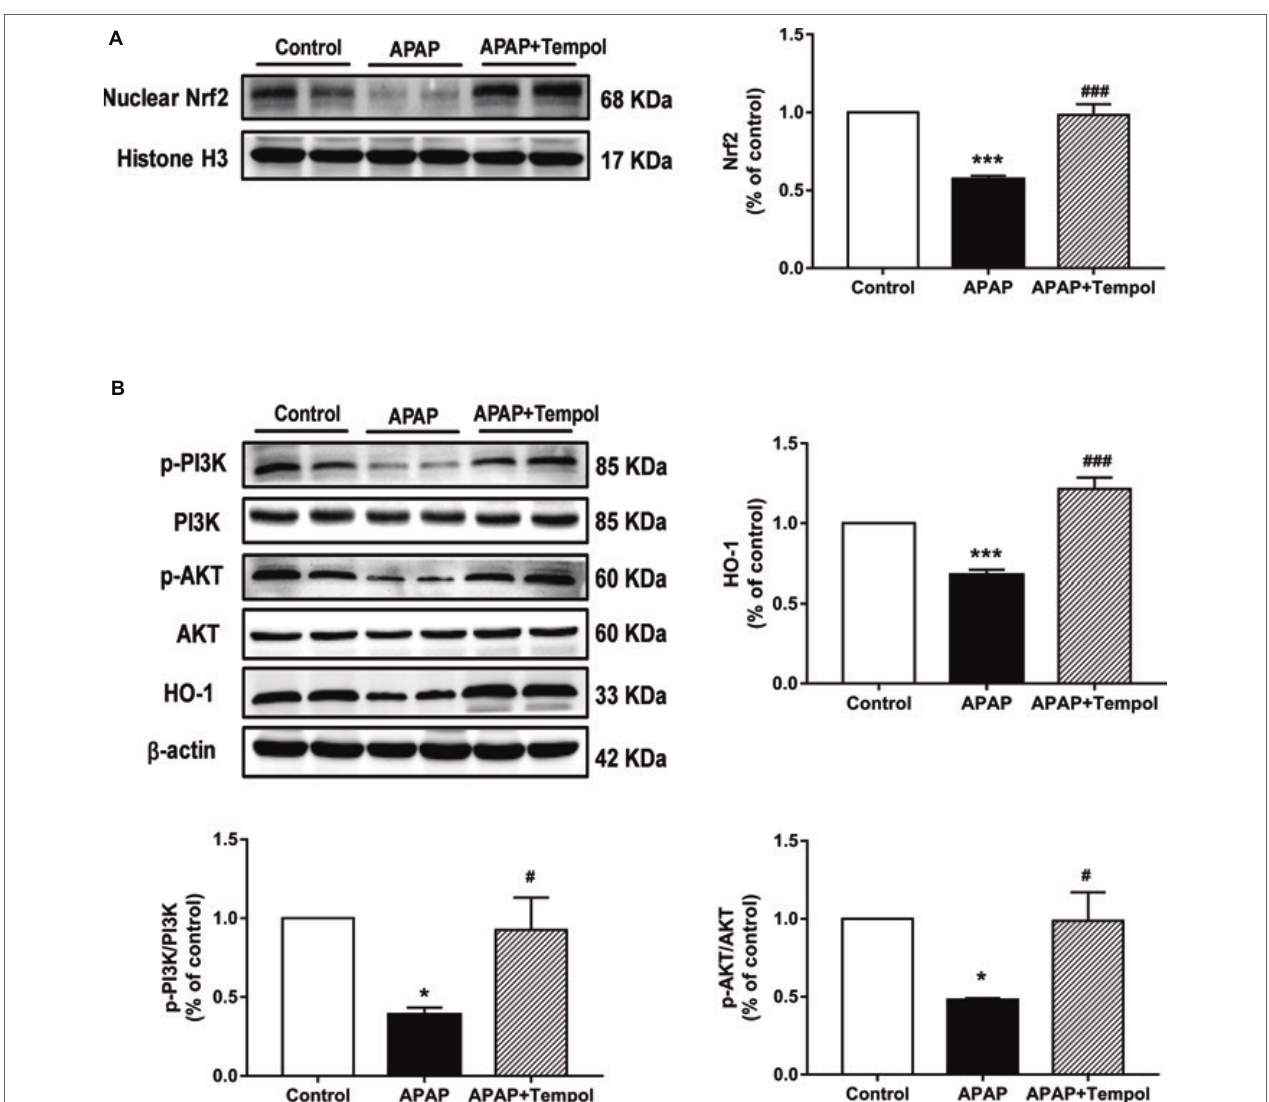
FIGURE 3 | Tempol protects against acetaminophen-induced acute hepatotoxicity via the PI3K/Akt/Nrf2 pathway in mice. (A) Protein expression of Nrf 2 in the nucleus of liver from the control mice (control), vehicle-treated hepatotoxicity mice (APAP), and tempol-treated hepatotoxicity mice (APAP + tempol). (B) Protein expressions of PI3K, Akt, and HO-1 and phosphorylation of PI3K and Akt in liver from three groups. Data are mean ± SEM. * p < 0.05 vs. control, # p < 0.05 vs. APAP, *** p < 0.001 vs. control, ### p < 0.001 vs. APAP, n =